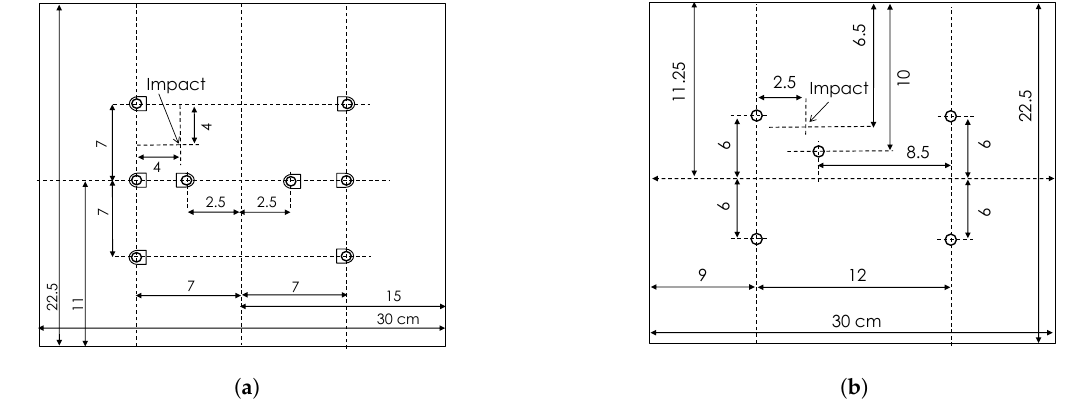
Figure 8. CFRP plate schematic with ( a ) DuraAct transducers and ( b ) SHM Layer, all distances in cm.